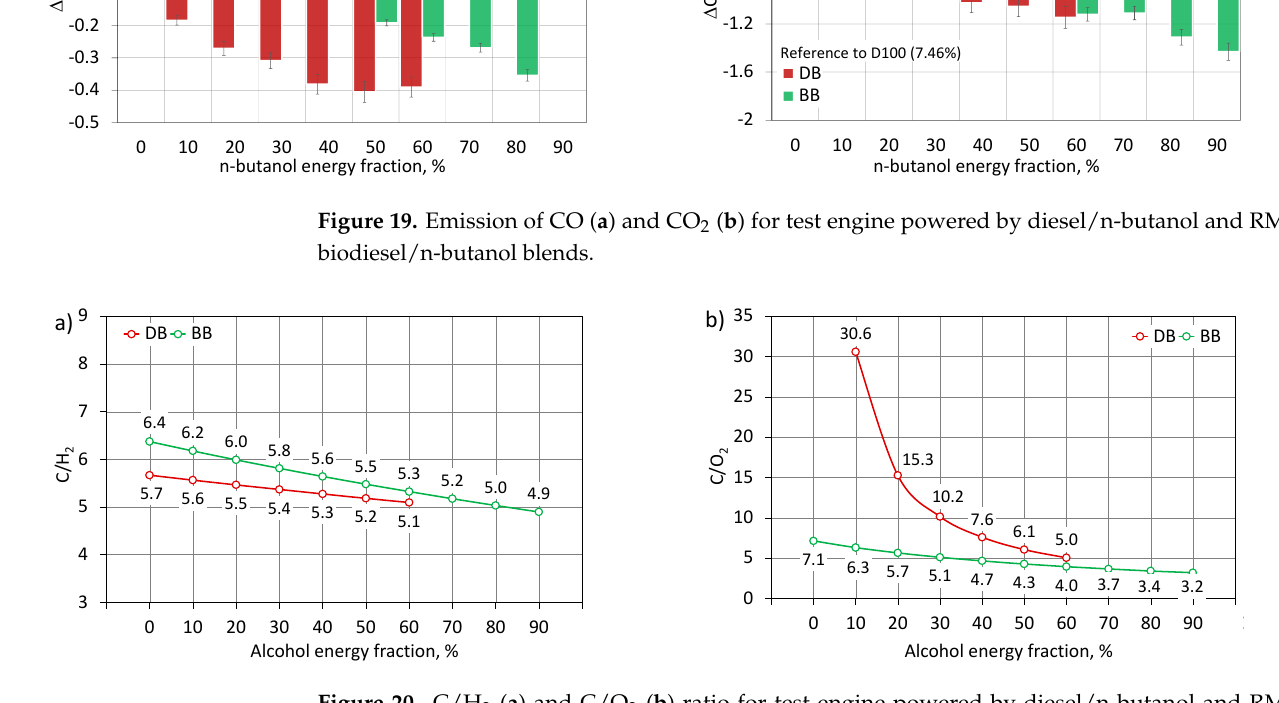
Figure 20. C/H 2 ( a ) and C/O 2 ( b ) ratio for test engine powered by diesel/n-butanol and RME biodiesel/n-butanol blends.